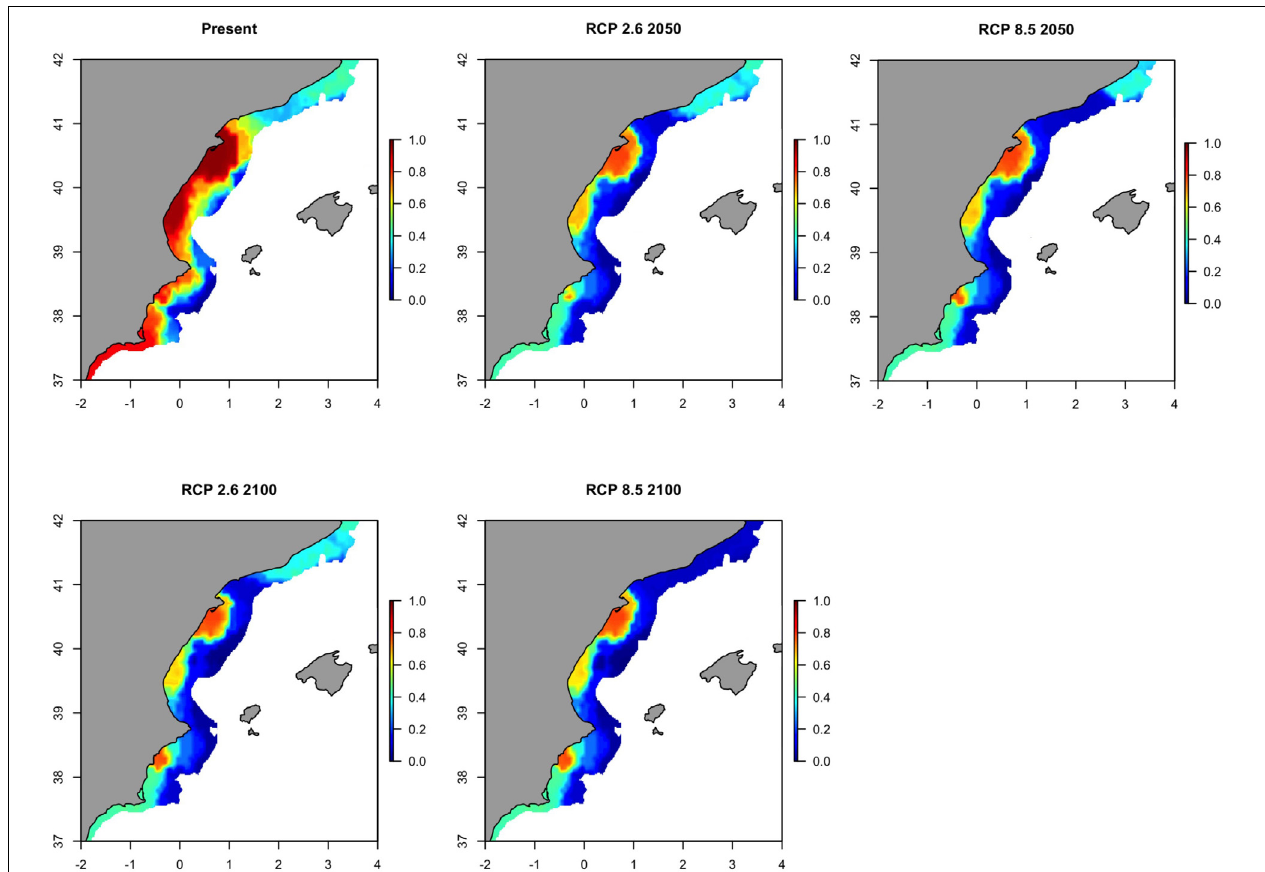
FIGURE 12 | Predicted probability of occurrence of the European anchovy ( Engraulis encrasicolus ) in Geographical Sub-Area 06 for the present situation and using IPCC scenarios obtained with RAC-BRT